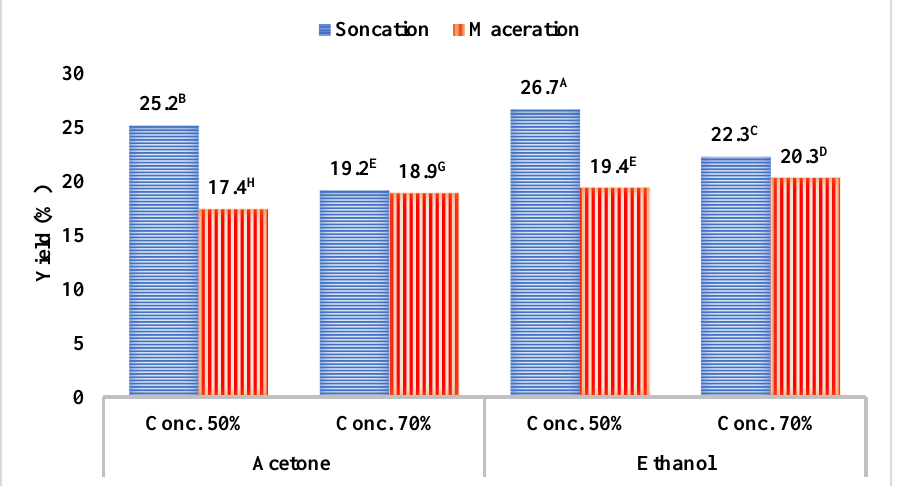
Figure 1. Yield (%) of lemongrass leaves extract by sonication and maceration technique. A–H means that the yields of different letters are significantly different.